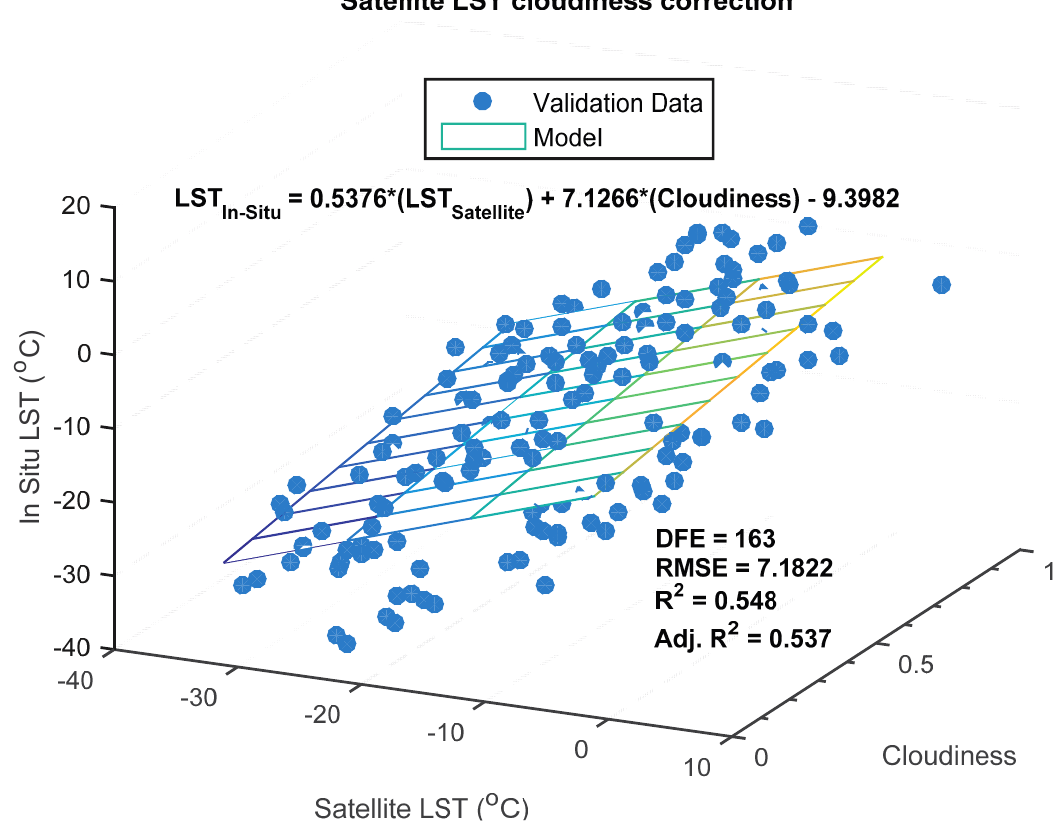
Figure 15. Three-dimensional scatterplot of in situ LST, VIIRS LST, and cloudiness with linear regression model in mesh-grid form to estimate in situ LST with RS LST and cloudiness as predictor